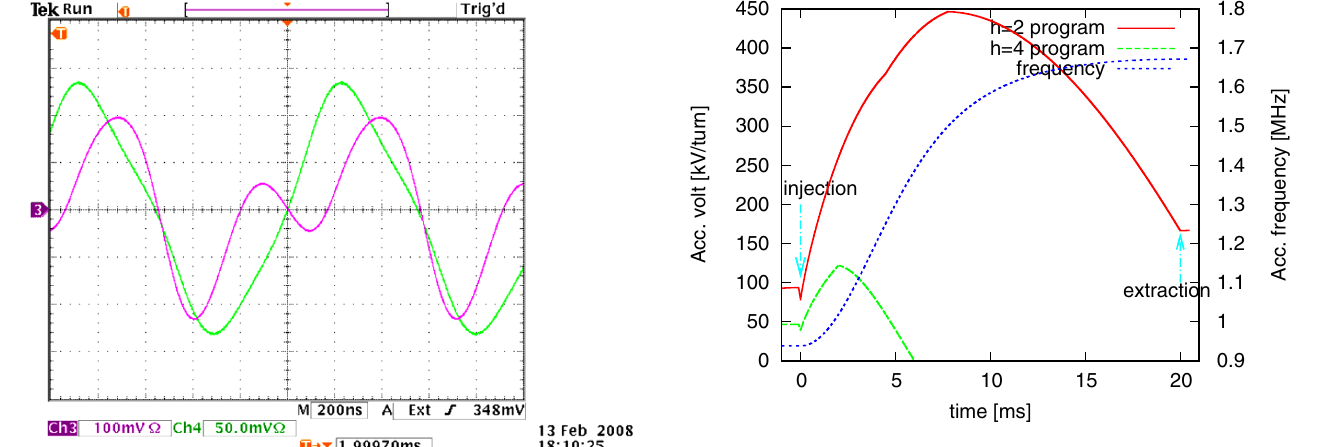
FIG. 15. (Color) Dual-harmonic acceleration pattern (voltage and frequency). The maximum ratio of ( h (cid:2) 4 ) is 0.5.FIG. 13. (Color) Fundamental rf frequency is 0.9 MHz.